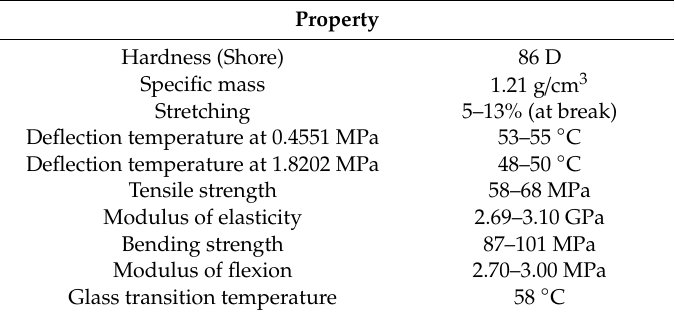
Table 1. Properties of the epoxy resin stereolithography (SLA)-Clear.